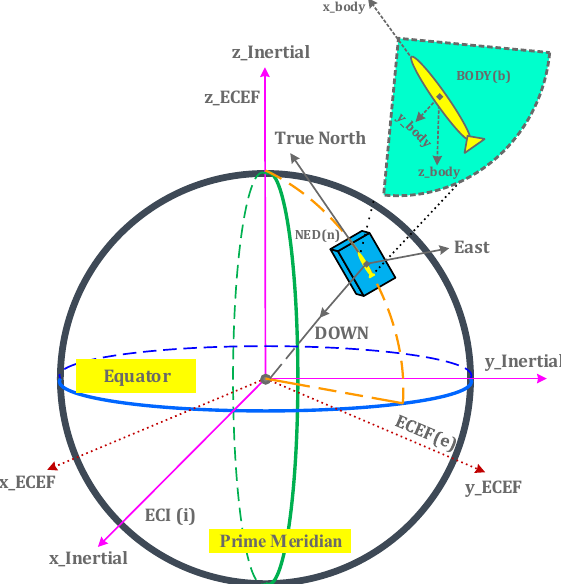
Figure 1. Frames of references: ECI, ECEF, NED and Body.